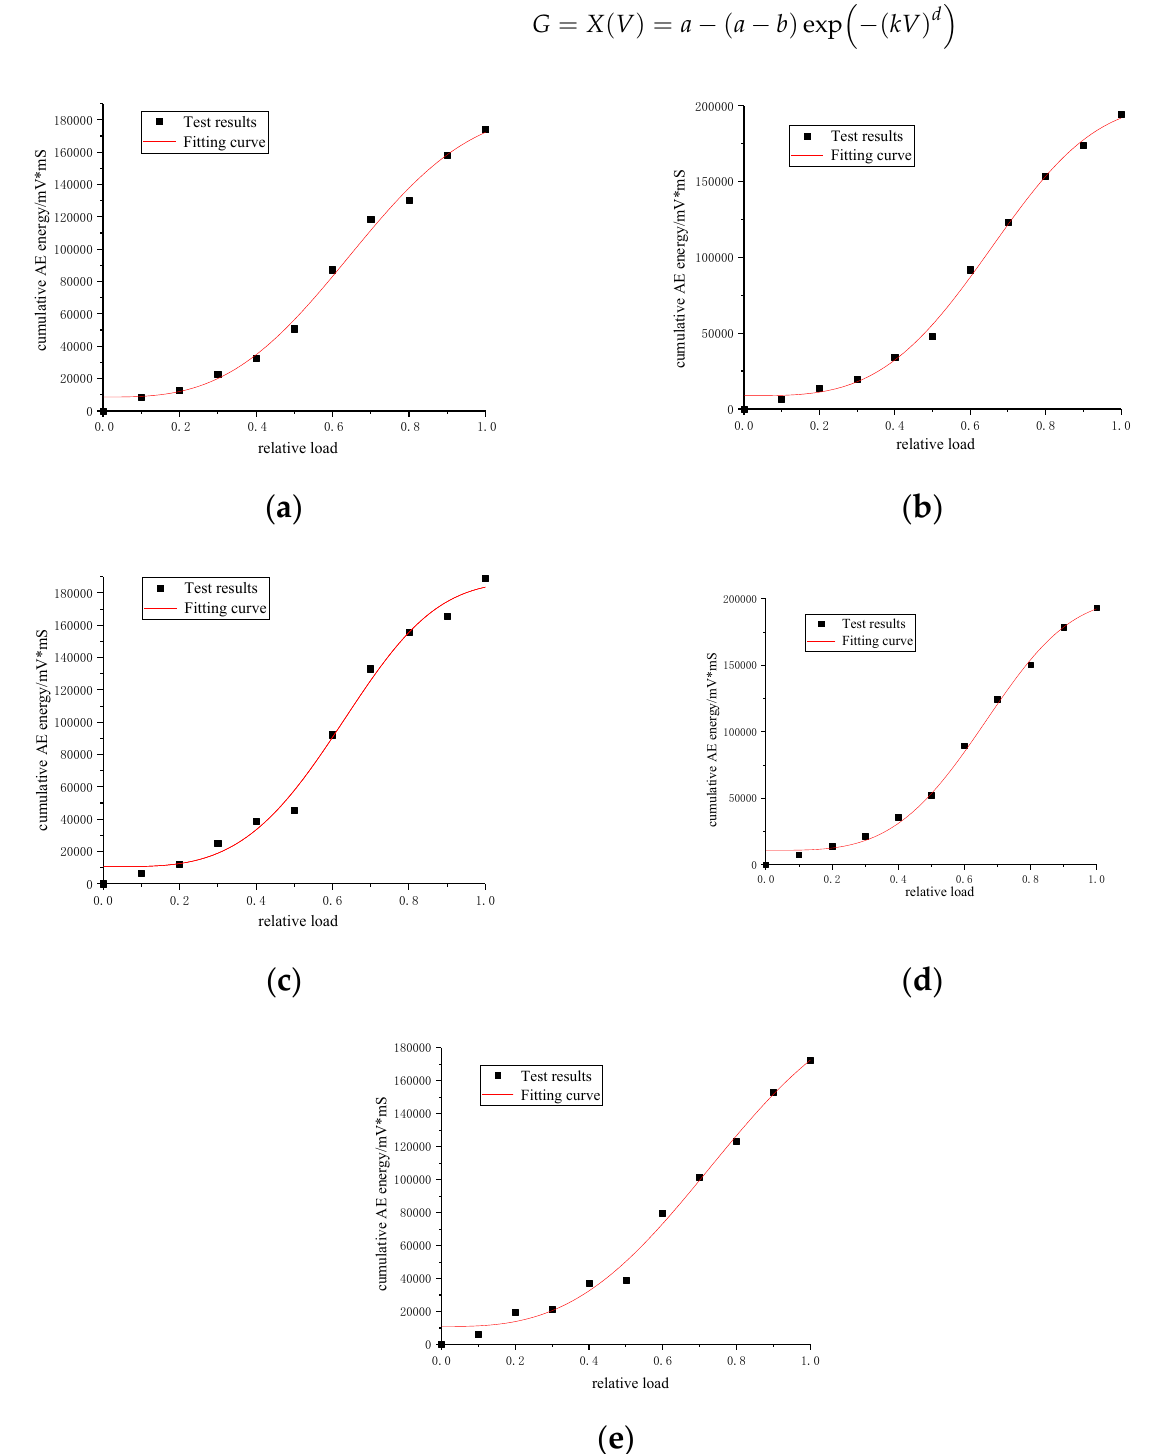
Figure 11. Cumulative energy-relative load fitting curve: ( a ) Test piece one; ( b ) Test piece two; ( c ) Test